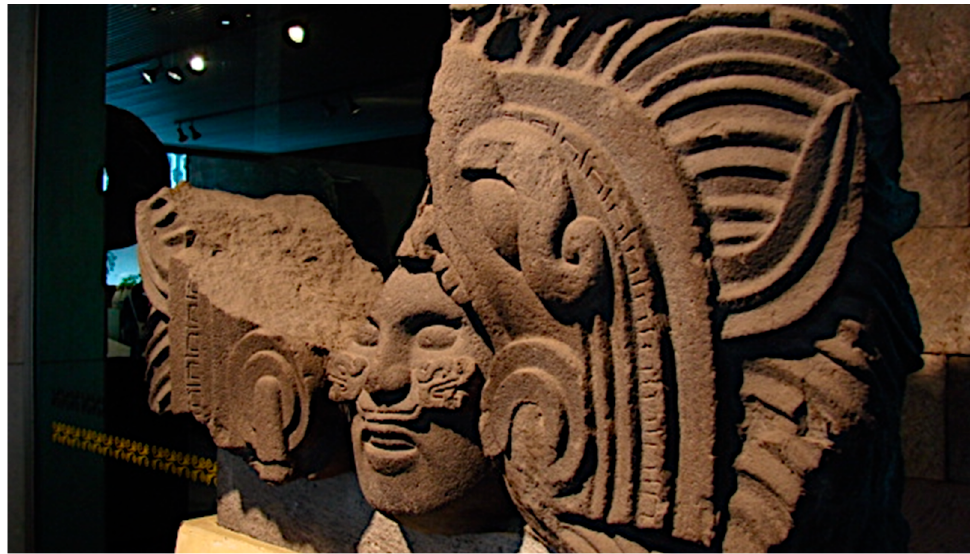
Figure 1. Quetzalcoatl emanating from the maws of the feathered serpent. Photo taken by 1st author at the National Museum of Anthropology, Mexico City, Mexico.